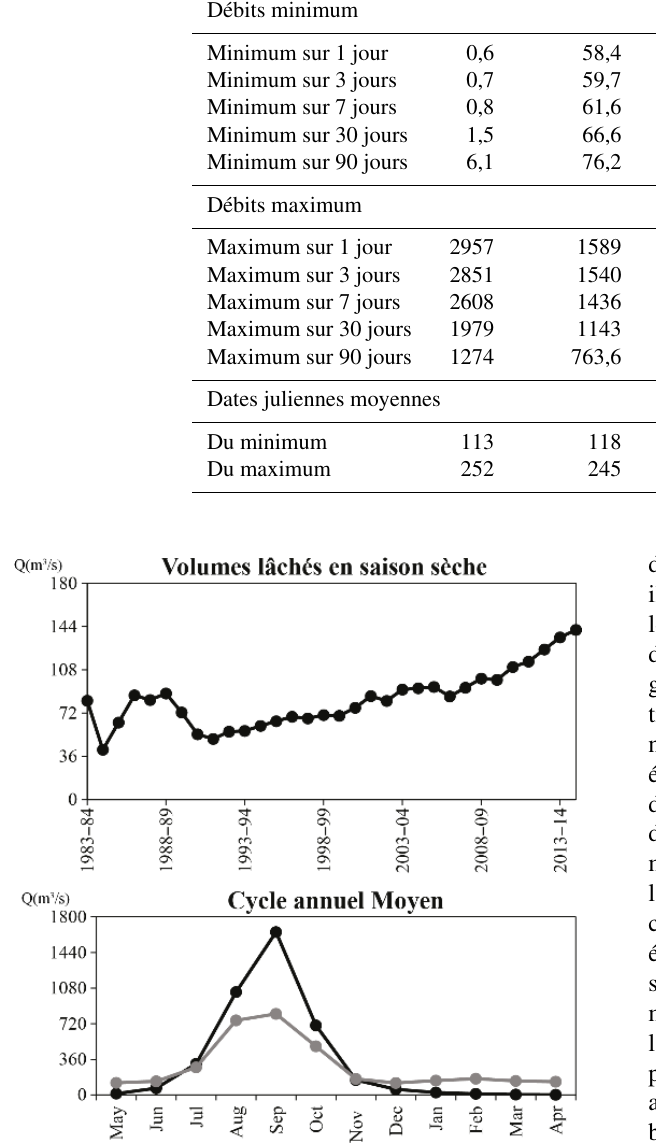
Figure 4. Evolution interannuelle des volumes lâchés à Lagdo de- puis 1983 et cycle annuel moyen de la Bénoué avant (en noir) et après (en gris) le